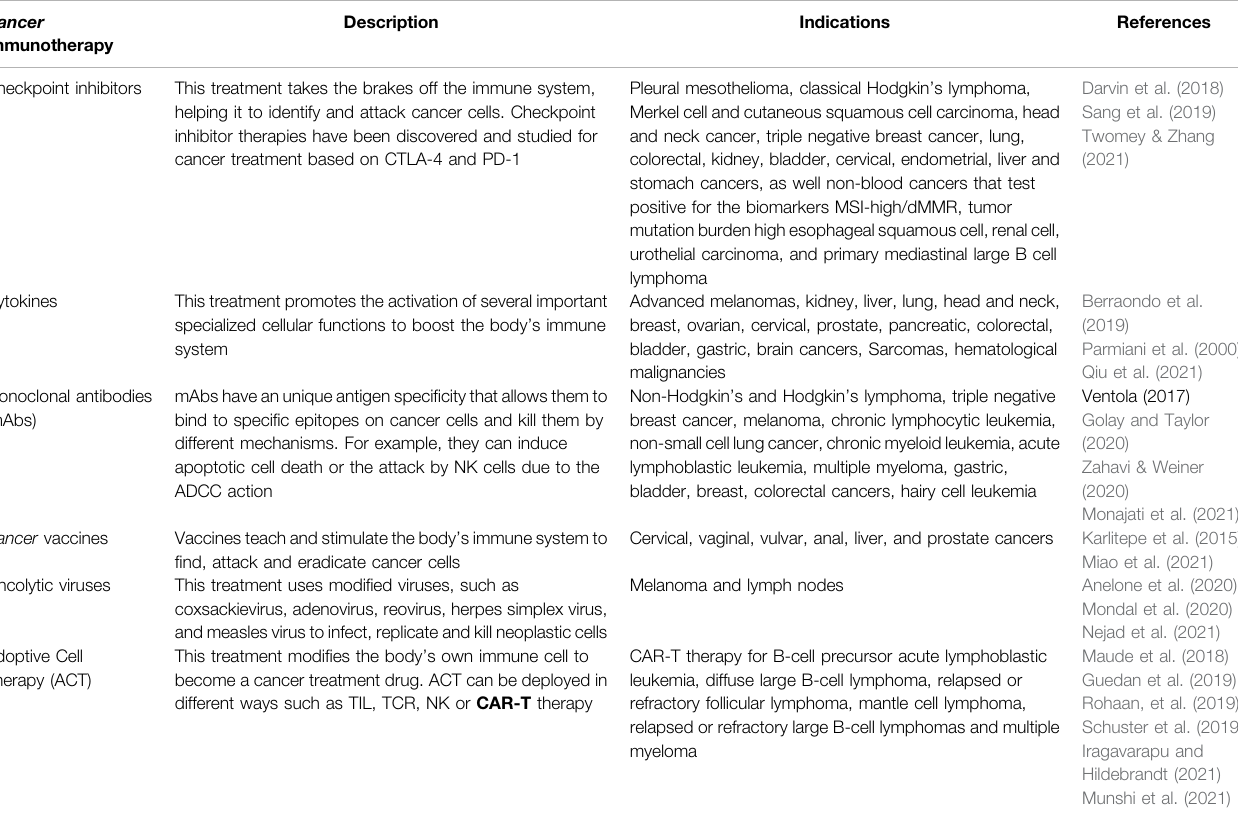
TABLE 1 | Six major kinds of cancer